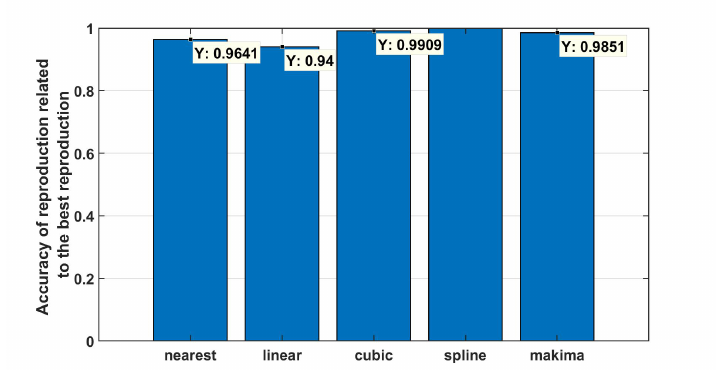
Figure 13. Accuracy of the reproduction related to the best reproduction of the individual interpolation methods.